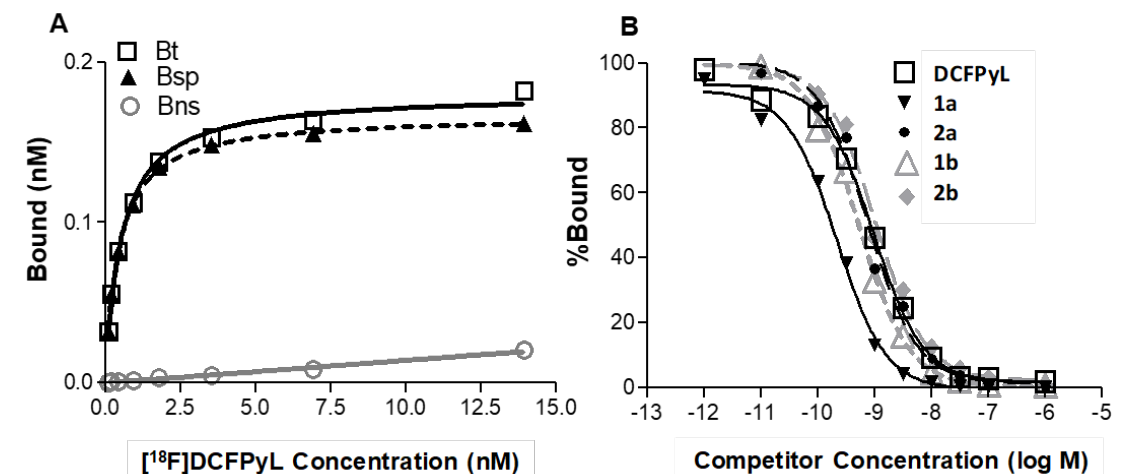
Figure 3. ( A ) Representative plot of [ 18 F]DCFPyL in vitro saturation binding assay using tumor membrane preparations from PC3(+); B t = Bound total; B ns = Bound non-specific; B sp = Bound specific (B t -B ns = B sp ); K d = 0.457 ± 0.011 nM (SE); n = 8 points). ( B ) Representative plot of [ 18 F]DCFPyL (with